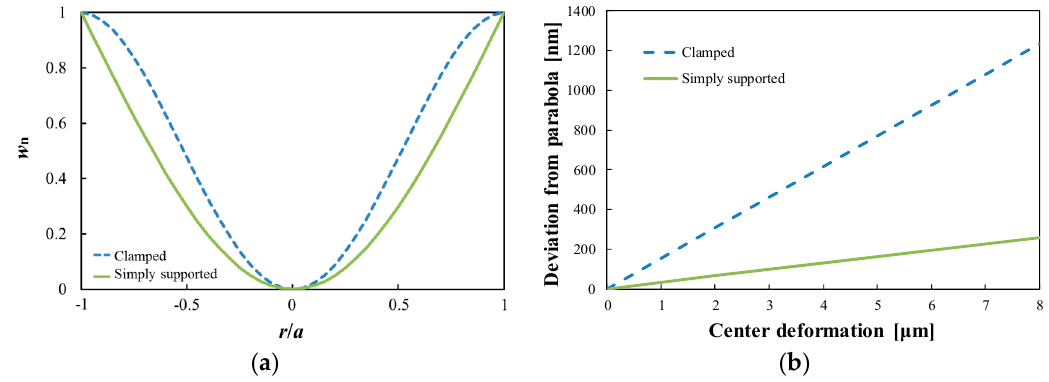
Figure 3. ( a ) Surface profiles of the circular plate at resonant frequency. ( b ) Comparison of the deviations from parabola between the clamped and simply supported conditions.